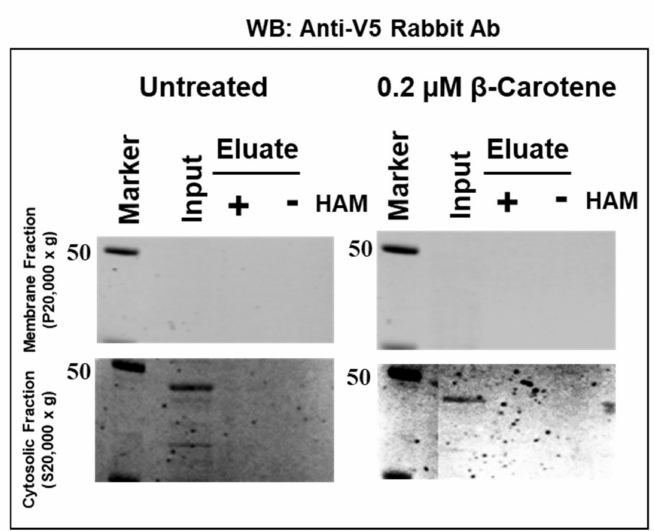
Figure 9. Analysis of palmitoylation of ACOLa in membrane (top panel) and cytosolic fraction (bottom panel) from HEK293F-expressed lysates treated with β -carotene as described in Materials and Methods. The presence of Acropora ACOLa was probed by immunoblotting with Anti-V5 mAb